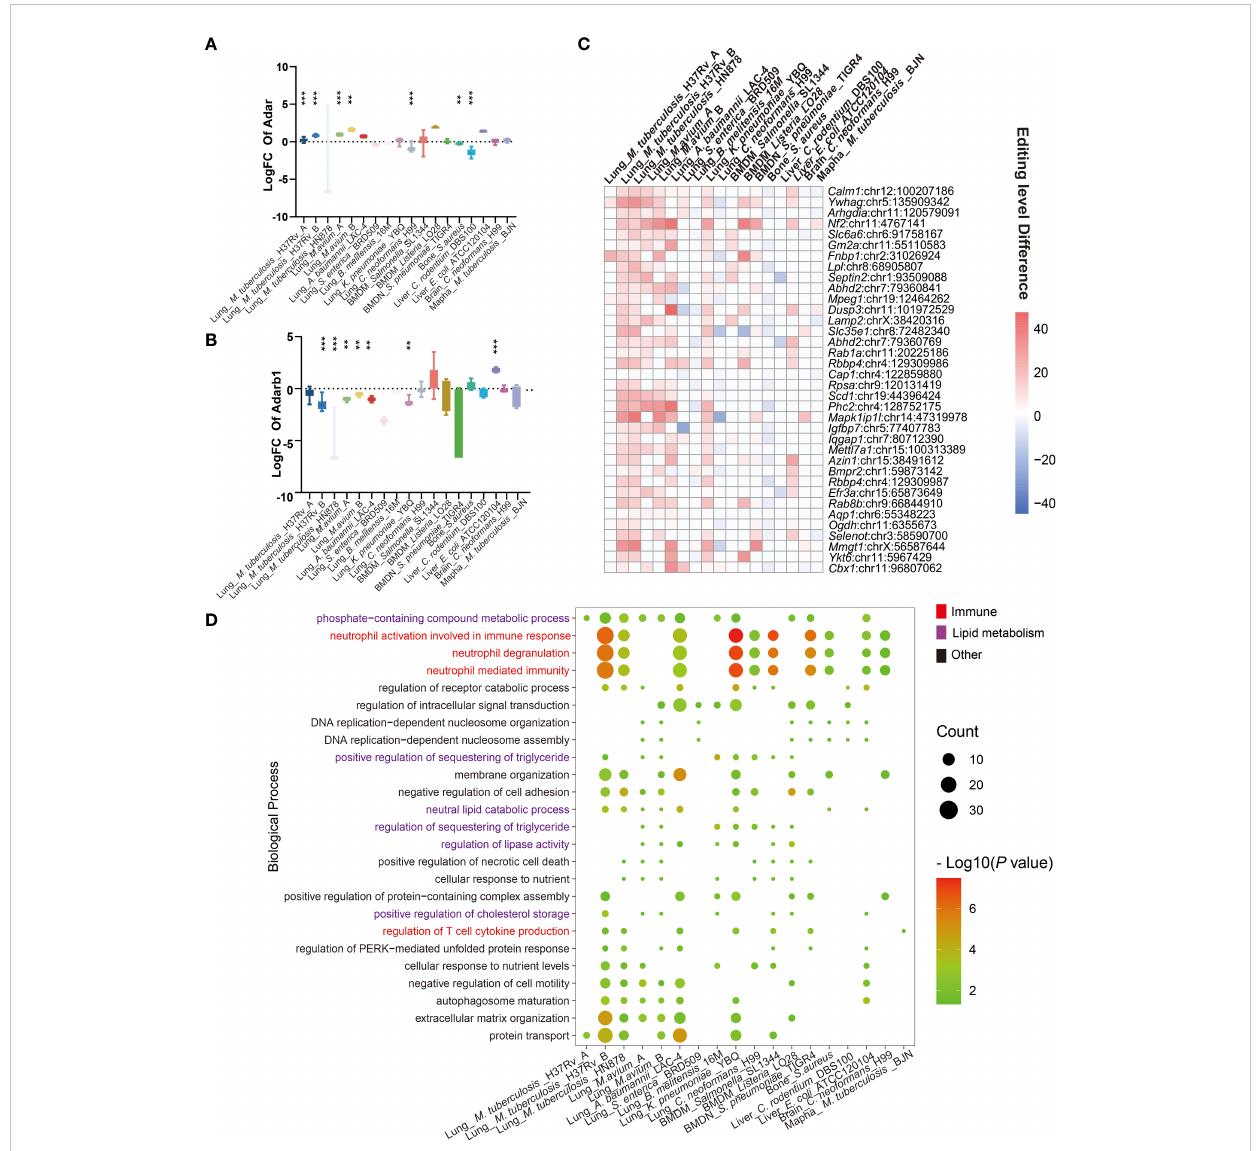
FIGURE 2 Consensus signature of A-to-I RNA editing in IBP infections. (A) The expression level differences of (A) Adar and (B) Adarb1 , are shown as log2 (Fold changes) (the infected/uninfected). (C) Heatmap of DRE sites shared by at least seven IBP infection datasets. The color of the squares represents the editing level difference of edited sites between the infected and uninfected samples). (D) The signi fi cance of biological processes enriched by DRE genes for each infection dataset is represented by the point size. (log10 ( P value)). Terms signi fi cantly enriched in at least seven IBP infection datasets are shown. The texts of immune-related items are colored in red. (The Student ’ s t-test is used for the inter-group comparisons of Adar and Adarb1 expression; ** P < 0.01; *** P <